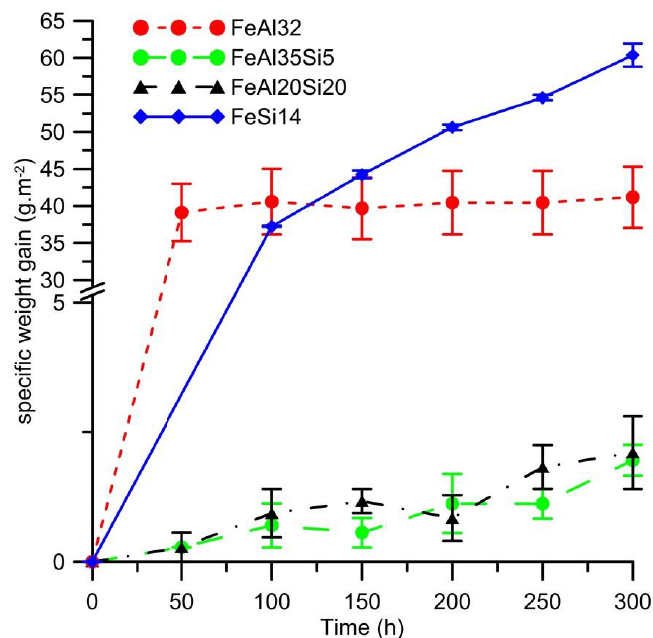
Materials 2018 , 11 , x FOR PEER REVIEW Figure 2. Dependence of specific weight gain (g.m − 2 ) on the duration of cyclic oxidation at 800 °C in air.